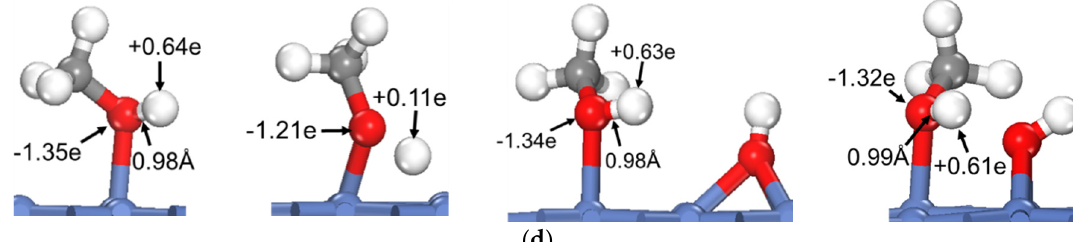
Figure 2. Structures and Bader charges in the oxhydryl dehydrogenation of H x COH with and without co- adsorbed OH: ( a ) x = 0, ( b ) x = 1, ( c ) x = 2, ( d ) x = 3. From left to right: local minimum and transition state structures of H x COH without and with co-adsorbed